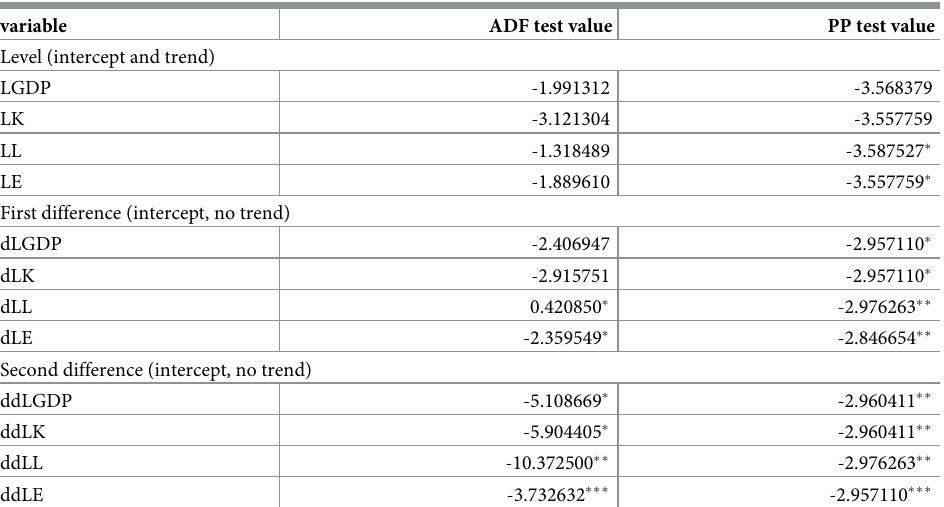
Table 1. Unit root test results of